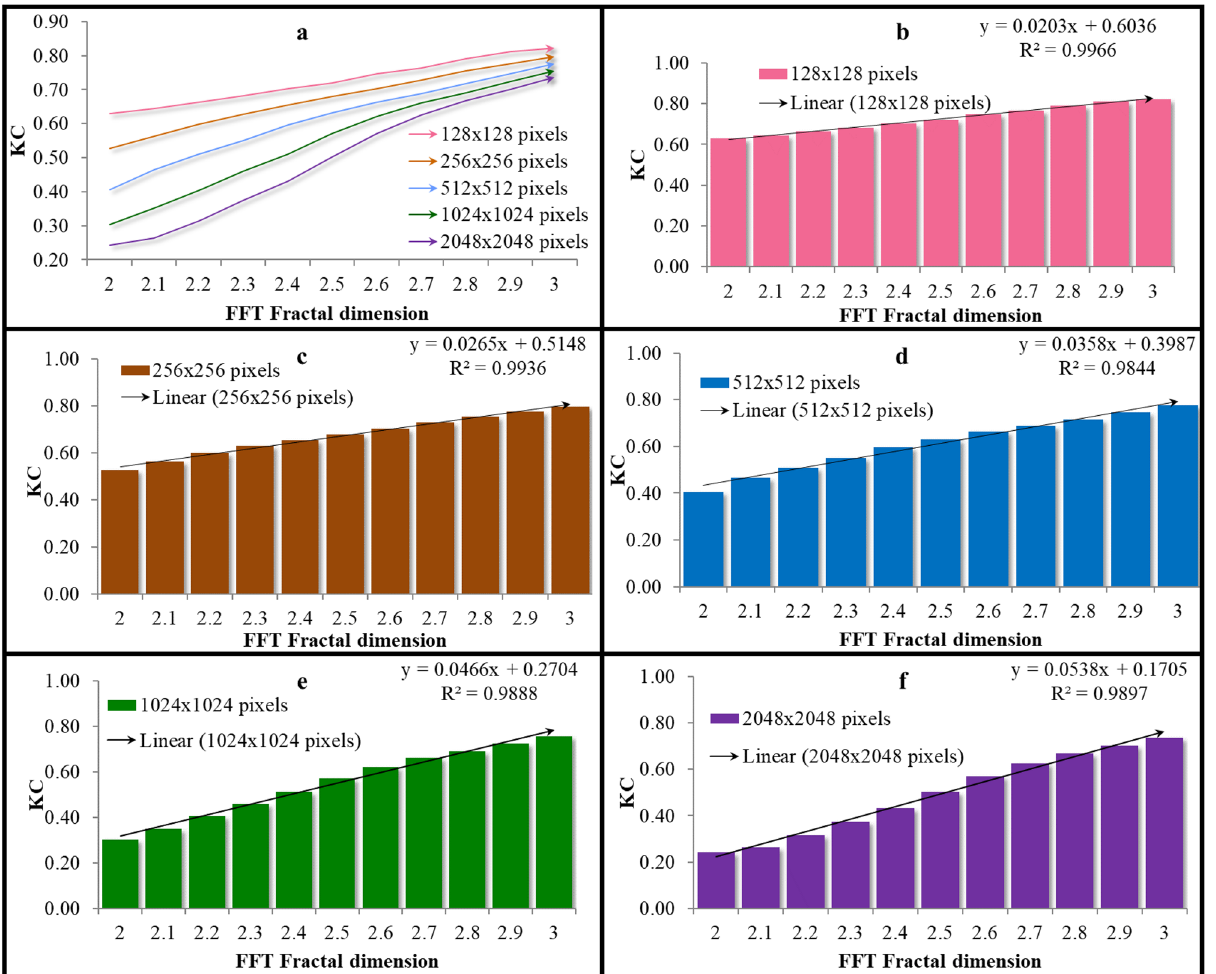
Figure 1. Testing the Kolmogorov Complexity (KC) analysis on automatically generated fractal surface images using the Inverse FFT algorithm. Each bar corresponds to averages for 20 generated images. ( a ) Absolute KC values without normalization, depending on the image resolution; ( b ) Normalized KC values, depending on the resolution of the images; ( c ) Normalized KC values for images with different fractal dimensions and a resolution of 256 × 256, ( d ) resolution of 512 × 512, ( e ) 1024 × 1024, ( f ) 2048 × 2048. Without KC normalization, images with different resolutions cannot be compared by KC ( a ), while KC normalization allows the comparison ( b ). At different resolutions ( c – f ), when images have the same FD (between 2.0 and 3.0) although the results are not similar, they are still comparable. It turns out that KC normalization allows differentiation of images even when they differ in size and